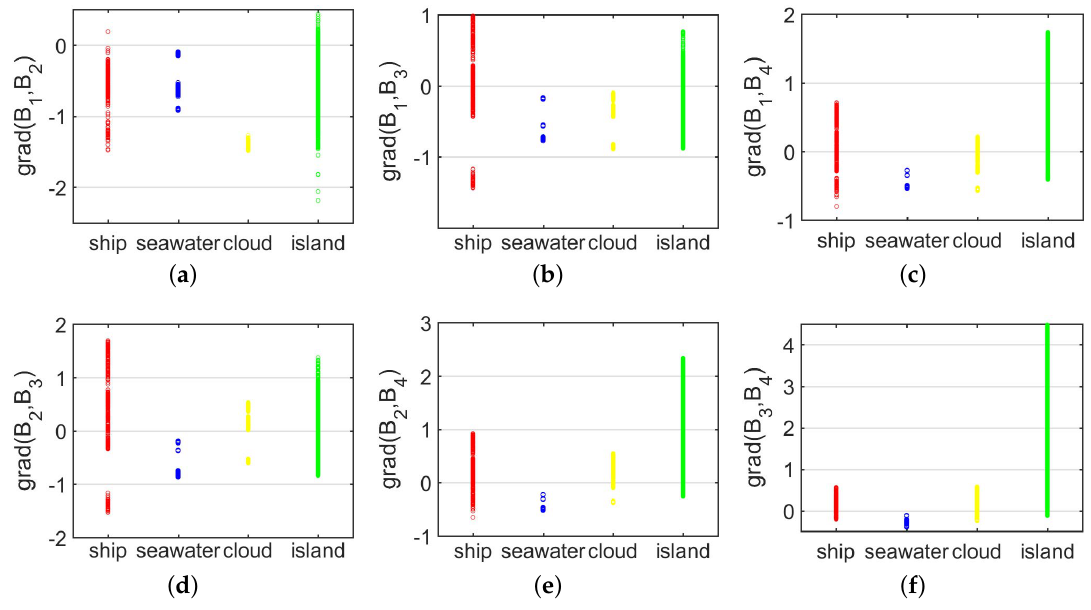
Figure 4. The reflectance gradients between two different bands for ships, seawater, clouds, and islands: ( a ) the reflectance gradients between band 1 and band 2; ( b ) the reflectance gradients between band 1 and band 3; ( c ) the reflectance gradients between band 1 and band 4; ( d ) the reflectance gradients between band 2 and band 3; ( e ) the reflectance gradients between band 2 and band 4; and ( f ) the reflectance gradients between band 3 and band